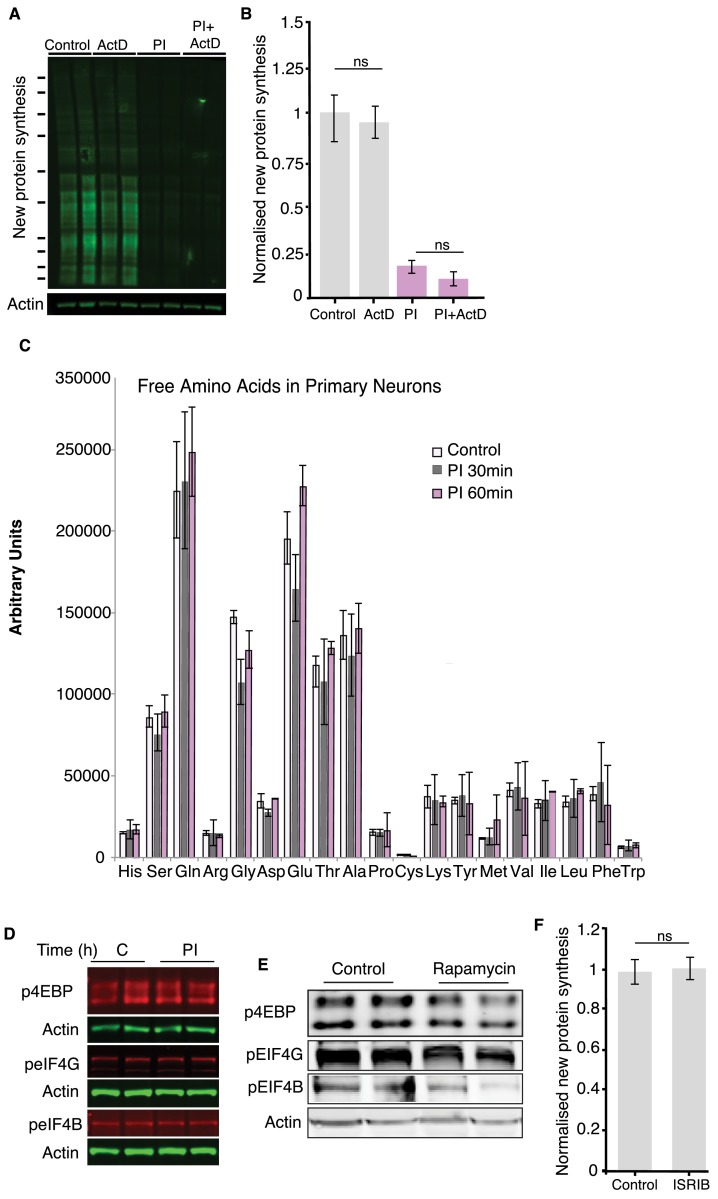
Effect of transcription inhibition on protein synthesis after proteasome inhibition and phosphorylation of other translation factors.(A) Representative western blot showing that blocking transcription with actinomycin D (10 µM, applied for 2 hr) did not reduce protein synthesis under control conditions or affect the PI-induced decrease in protein synthesis. Actin is shown as a loading control. Two biological replicates per condition are shown. (B) Analysis of experiments shown in A. ActD treatment did not significantly alter protein synthesis under control conditions (p>0.05) nor did it significantly alter the PI-induced decrease in protein synthesis (p>0.05), three experiments. (C) Free amino acid content of primary neurons, measured after 30 and 60 min of proteasome inhibition. All experiments were performed in primary rat hippocampal neurons. (D) Western blot analysis of indicated translation initiation factors and binding proteins showing that proteasome inhibition by MG132 (20 μM; 2 hr) did not alter the phosphorylation levels of 4EBP1/2, eIF4B or eIF4G. Actin is shown as a loading control. (E) Neurons were treated with Rapamycin for 2 hr to confirm the specificity of the used phospho-antibodies. These antibodies are widely used and their specificity has been demonstrated previously. (F) The small molecule inhibitor ISRIB did not significantly alter protein synthesis under basal conditions, control vs. ISRIB, (p>0.05, non-significant, unpaired t-test, four experiments).Figure 2—figure supplement 1—source data 1.Source data for Figure 2—figure supplement 1B, C, F.Figure 2—figure supplement 1—source data 2.Source data for Figure 2—figure supplement 1A, D.